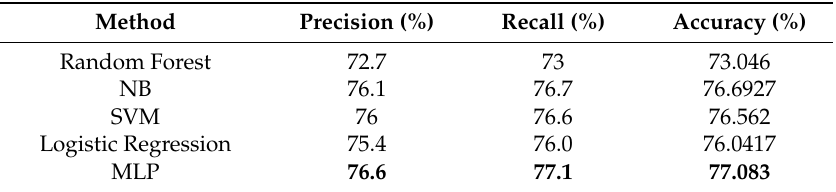
Table 2. The performance comparison of the classifiers for diabetes